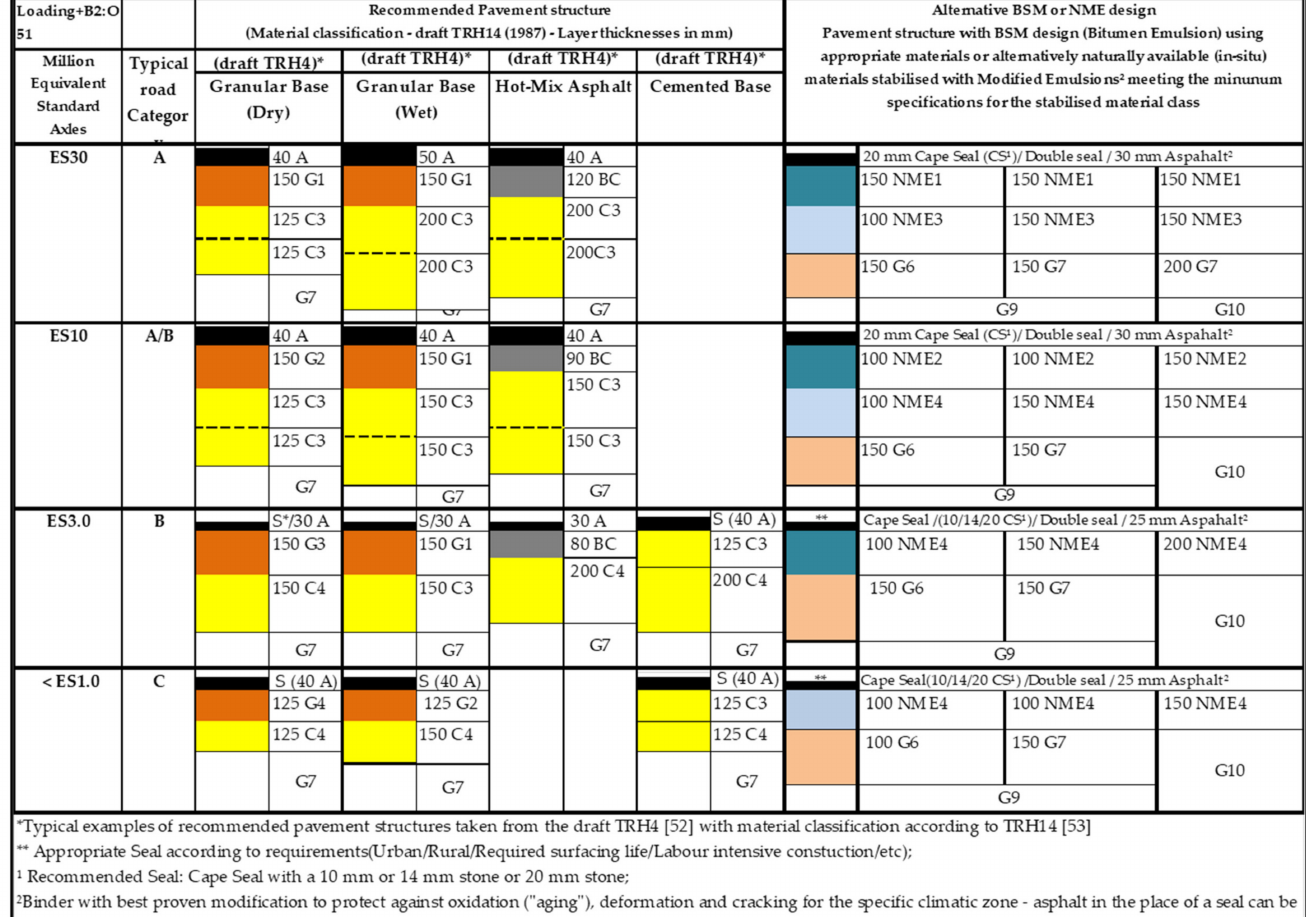
Figure 27. Comparative pavement designs based on high-quality crushed stone and/or cement-treated materials with relatively thin surfacings and the newly recommended NME stabilised designs using naturally available